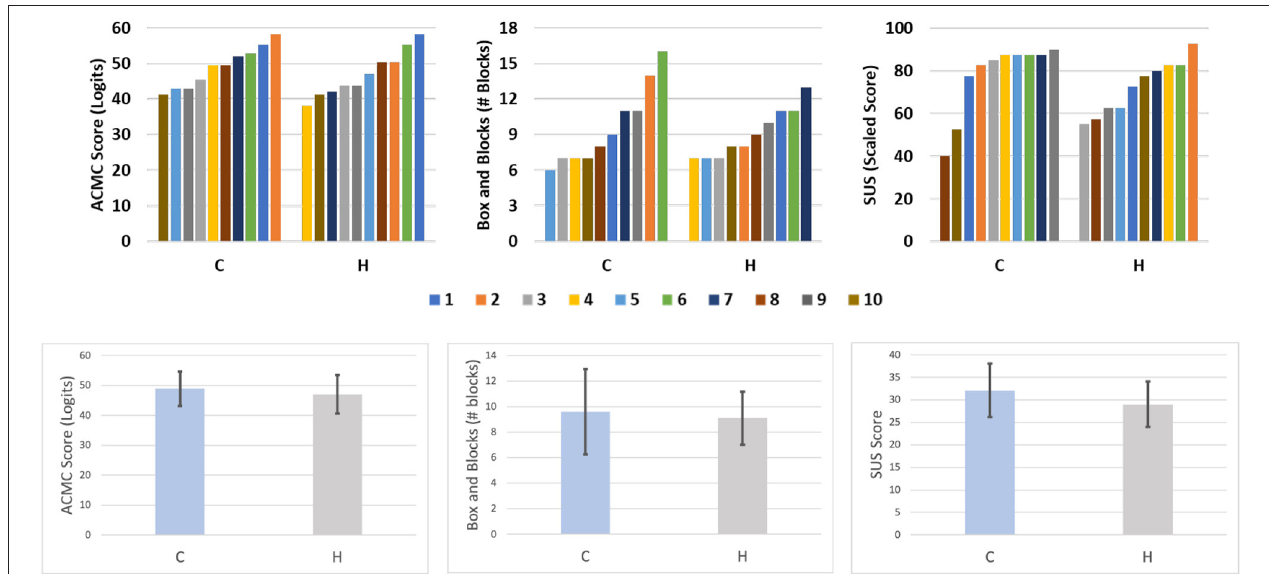
FIGURE 6 | Results of limb-intact subjects on the ACMC, BBT, and SUS for each configuration presented individually, color-coded by subject, in the top row and in group form in the bottom row. Group results are presented as bar plot, the black bar denotes the standard deviation.